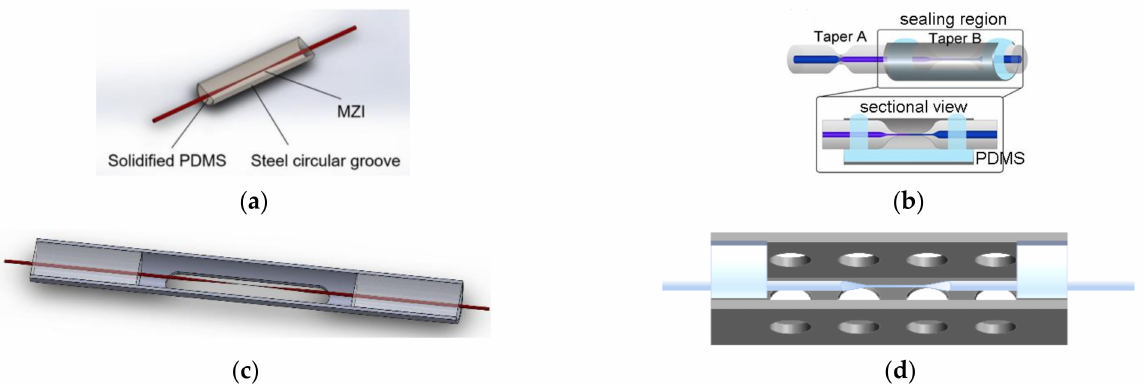
Figure 8. Schematic diagram of ( a ) full-encapsulated [116] and ( b ) part-encapsulated MMZI in a stainless steel C-type slot [104]. ( c , d ) Improved encapsulation method of MMZI